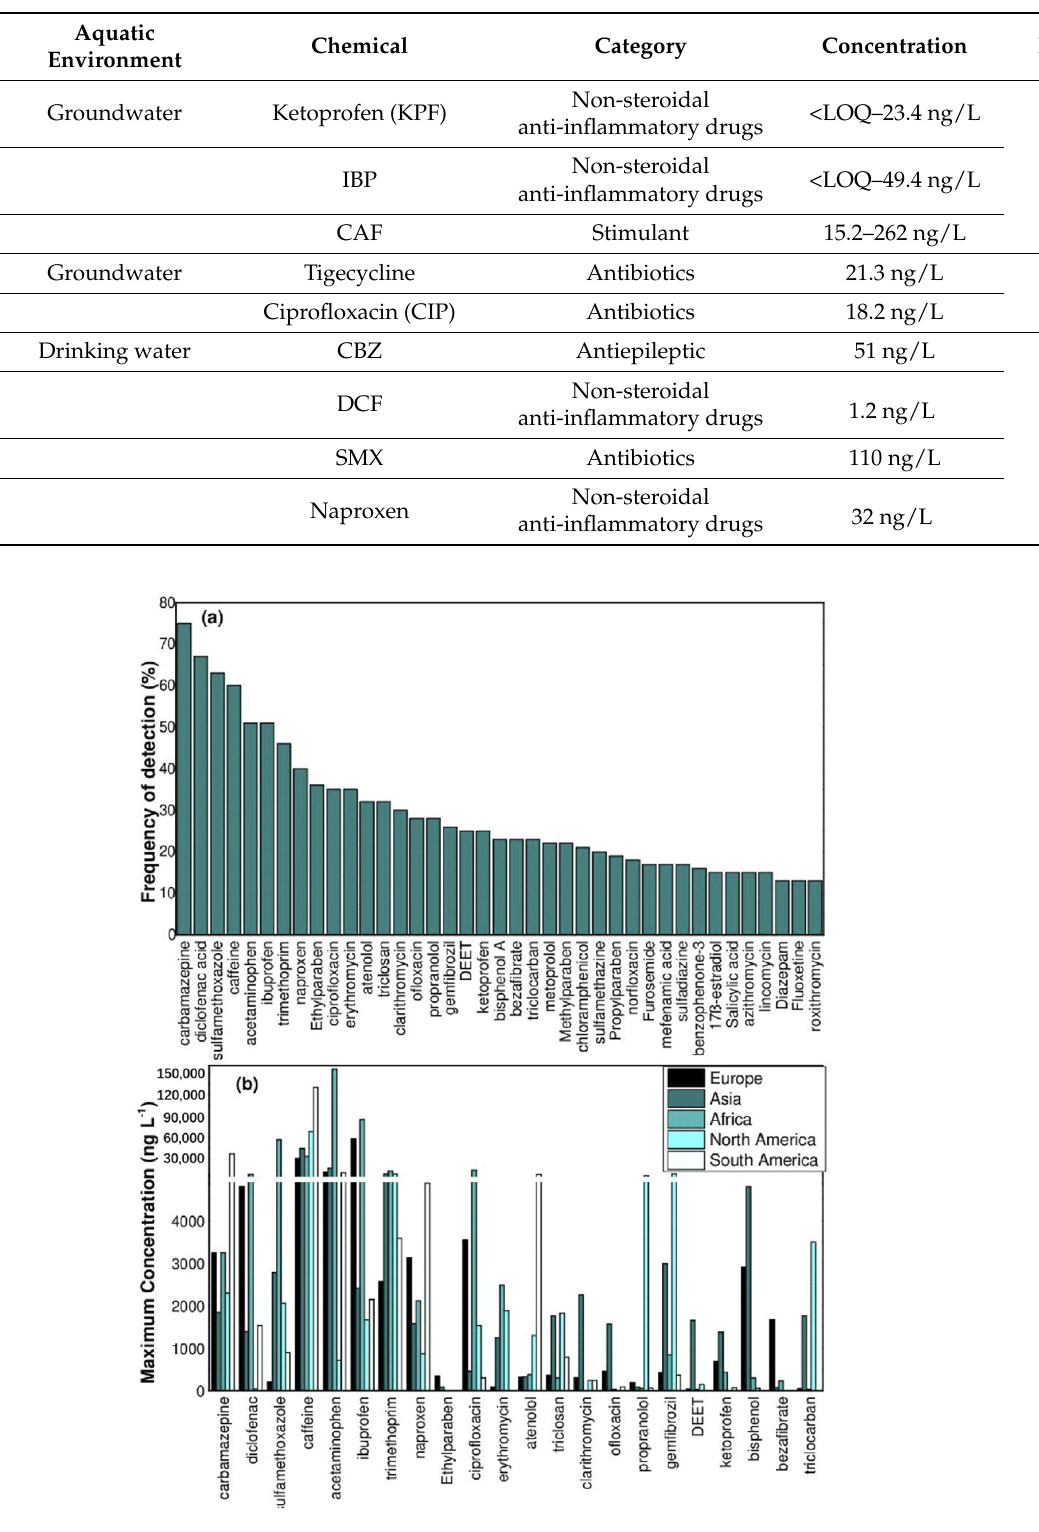
Figure 1. Detection results of PPCPs in surface water. ( a ) Detection frequencies of 104 articles; ( b ) the maximum concentrations (ng/L) of the most detected PPCPs in each analyzed continent. Reproduced with permission from [23].